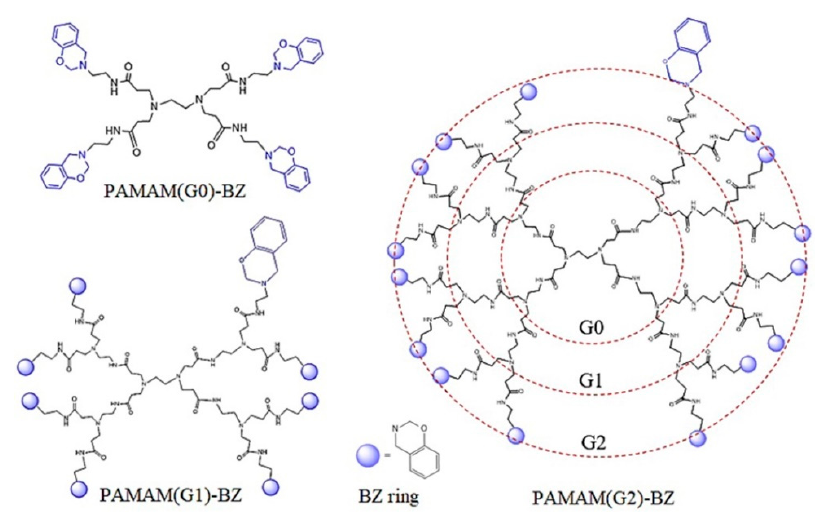
Figure 3. The final structures of benzoxazine (BZ) monomers obtained from poly(amidoamine) (PAMAM) dendrimers .